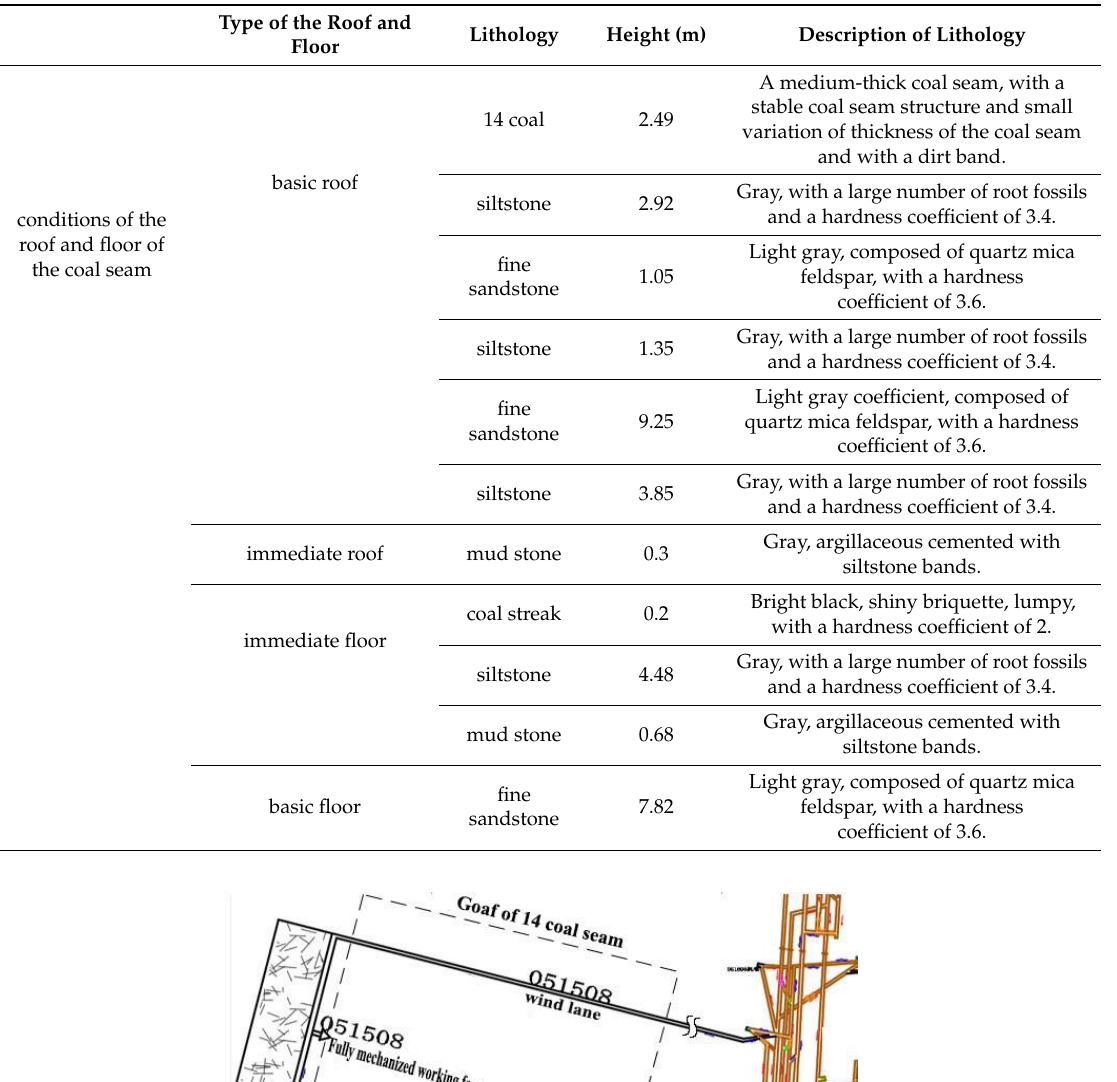
Table 1. Lithology of the roof and the floor of the coal seam .